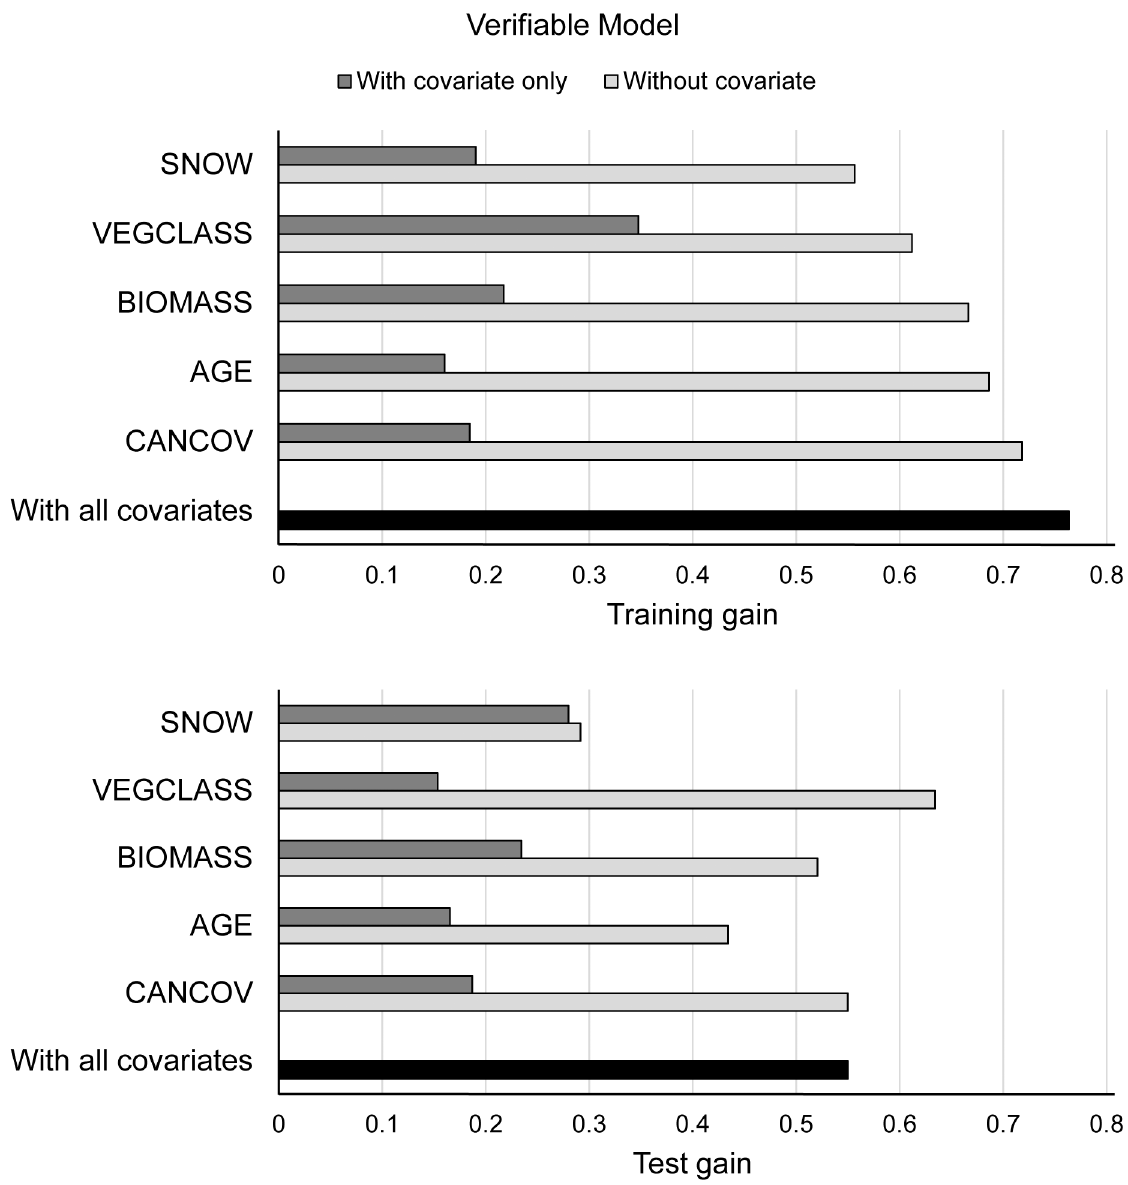
Fig 2. Results from jackknife tests of regularized training gain (upper graph) and test gain (lower graph) generated by running the final verifiable fisher distribution model in Maxent with an independent test